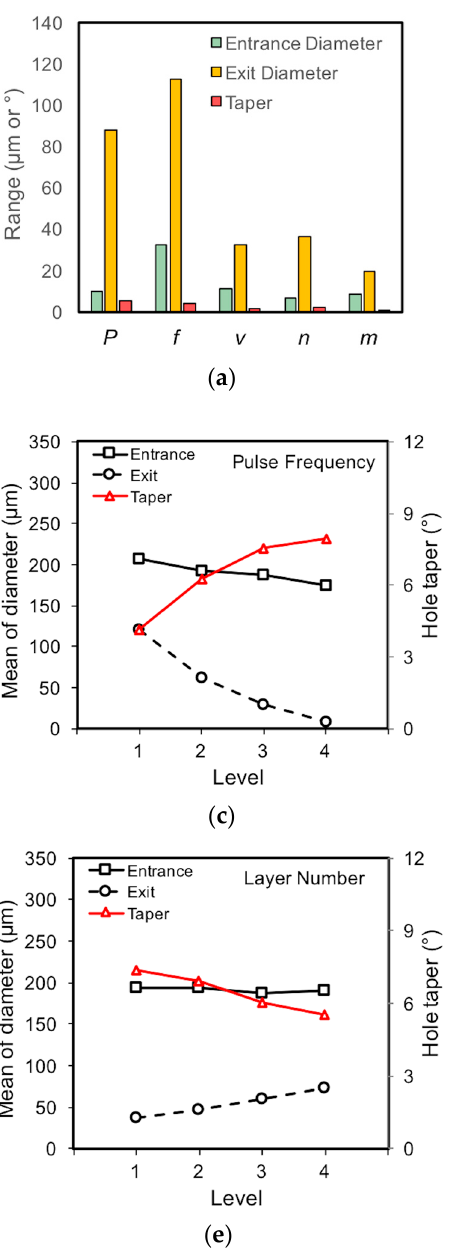
Figure 7. Effects of processing parameters on direct trepanning results, where ( a ) is the range analysis result, and ( b – f ) correspond to the laser power, pulse frequency, scanning velocity, layer number, and element number, respectively.